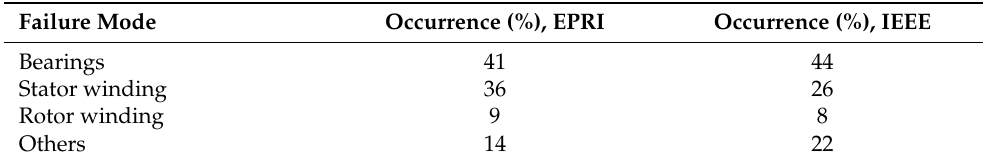
Table 2. IM failures modes According to EPRI and IEEE surveys.